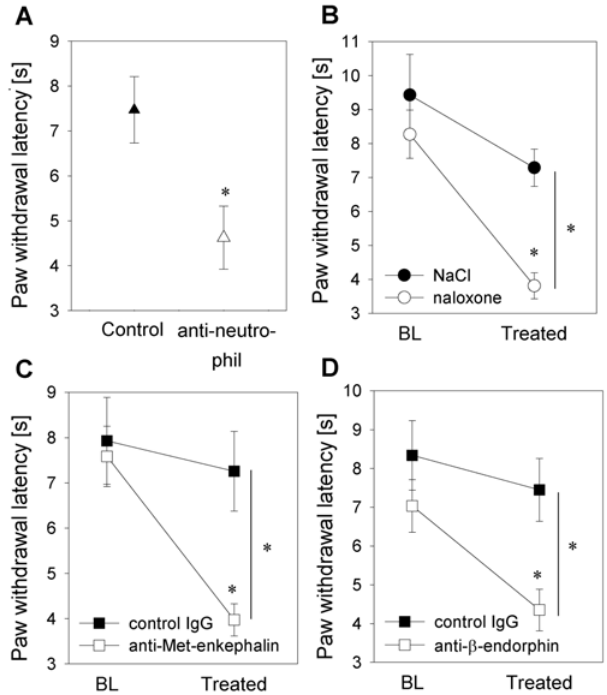
Figure 1. Neutrophils attenuate inflammatory pain by local opioid peptide release. [ A ] In a rat model, inflammation was induced by intraplantar injection of heat-inactivated Mycobacterium butyricum (complete Freund’s adjuvant). Prior to induction of inflammation, rats were pretreated with i.v. anti-neutrophil serum (open triangles). Control animals received non-immune rabbit serum (filled triangle). Two hours after complete Freund’s adjuvant inoculation thermal nociceptive thresholds (i.e. paw withdrawal latency) were significantly decreased in neutropenic rats (n=6–8; * p , 0.05, t-test). [ B, C ] To examine the role of endogenous opioids in local inflammatory pain control, rats with complete Freund’s adjuvant-induced inflammation were intraplantarly injected with the opioid receptor antagonist naloxone (0.56 ng, control solvent only; open and filled circle respectively; baseline, BL [ B ]) (n=9– 14), with an anti-opioid peptide antibody (i.e. anti-Met-enkephalin,